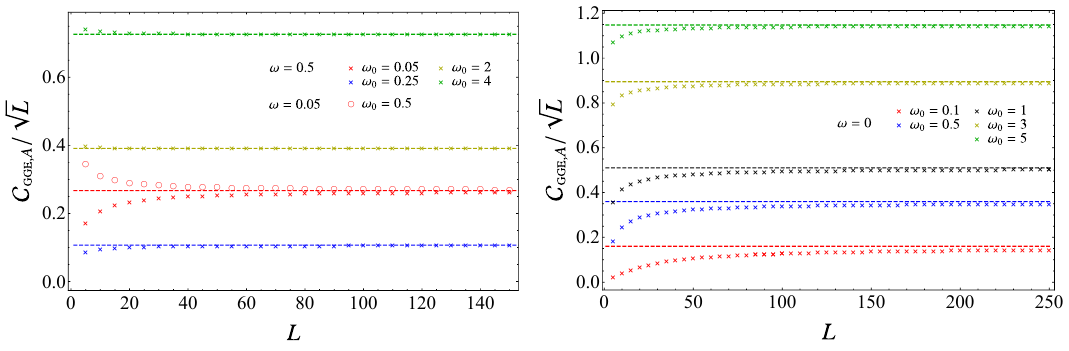
Figure 22 . Asymptotic value of C either in the infinite chain (left panel) or adjacent to the origin of a semi-infinite chain with DBC (right panel). The horizontal dashed lines show C support the last equality in